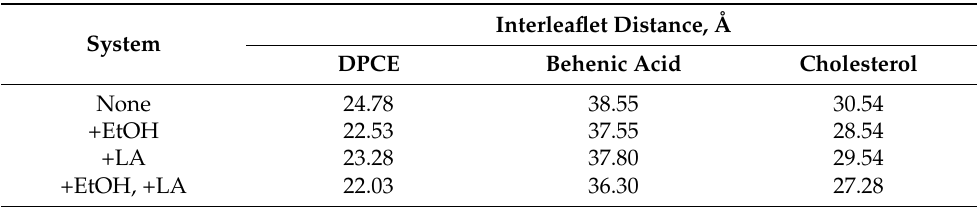
Figure 2. Density profiles of individual components of SC membranes, CPEs, and water for systems with and without CPEs: ( a ) SC bilayer without CPEs (the color code is the same for panels c, e, and f); ( b ) Density profiles for cholesterol without CPEs, with individual CPEs, and with their combination; ( c ) SC bilayer with both ethanol and linoleic acid; ( d ) Enlarged density of ethanol and water inside the hydrophobic region of SC membranes simulated with both ethanol and linoleic acid (solid line) and only with ethanol (dashed line); ( e ) SC bilayer with both ethanol; ( f ) SC bilayer with linoleic acid. Table 2. Interleaflet distance measured between average positions of P1, SP1, and SP1 CG beads of DPCE, behenic acid, and cholesterol, respectively, in two SC